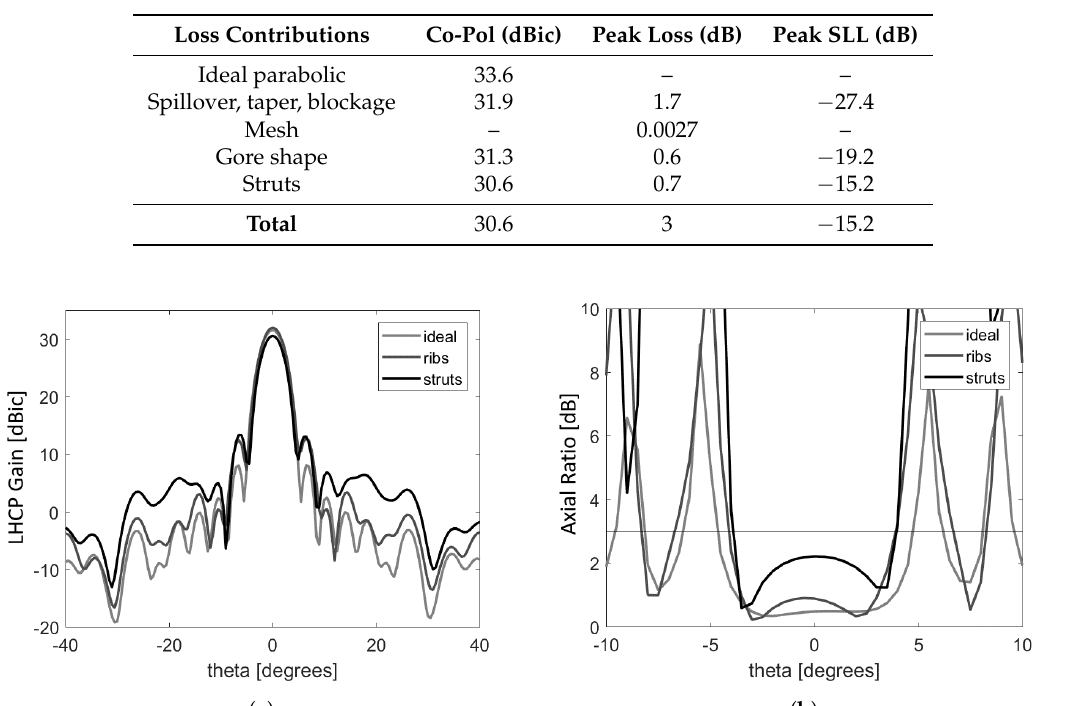
Table 6. Illumination losses at 1.275 GHz: effect of antenna elements on the co-polarized gain (Co-Pol), peak gain losses and peak sidelobe levels (Peak SLL).